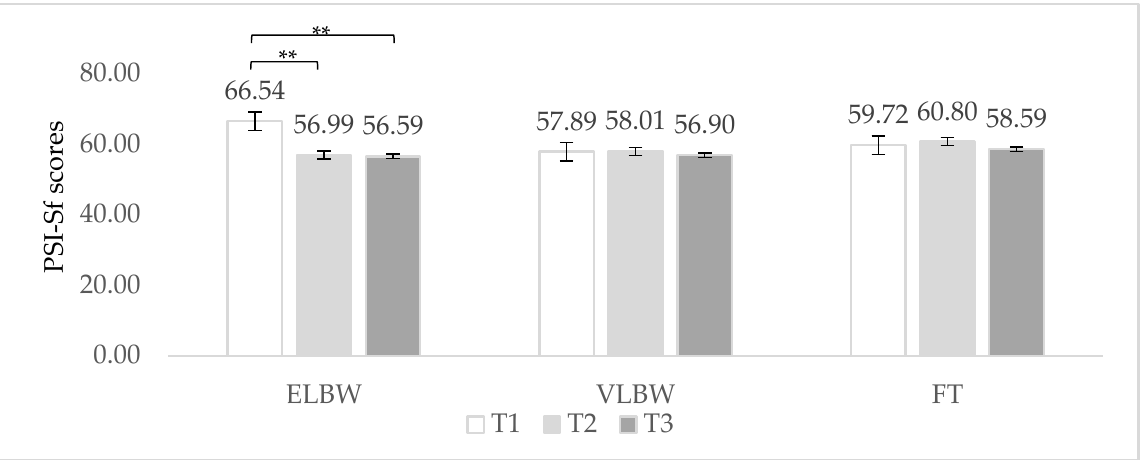
Figure 2. Fathers’ PSI total score related to birth weight and time of assessment. Note. ELBW = extremely low birth weight; VLBW = very low birth weight; FT = full-term; T1 = 3 months; T2 = 9 months; T3 = 12 months. ** p < 0.005.